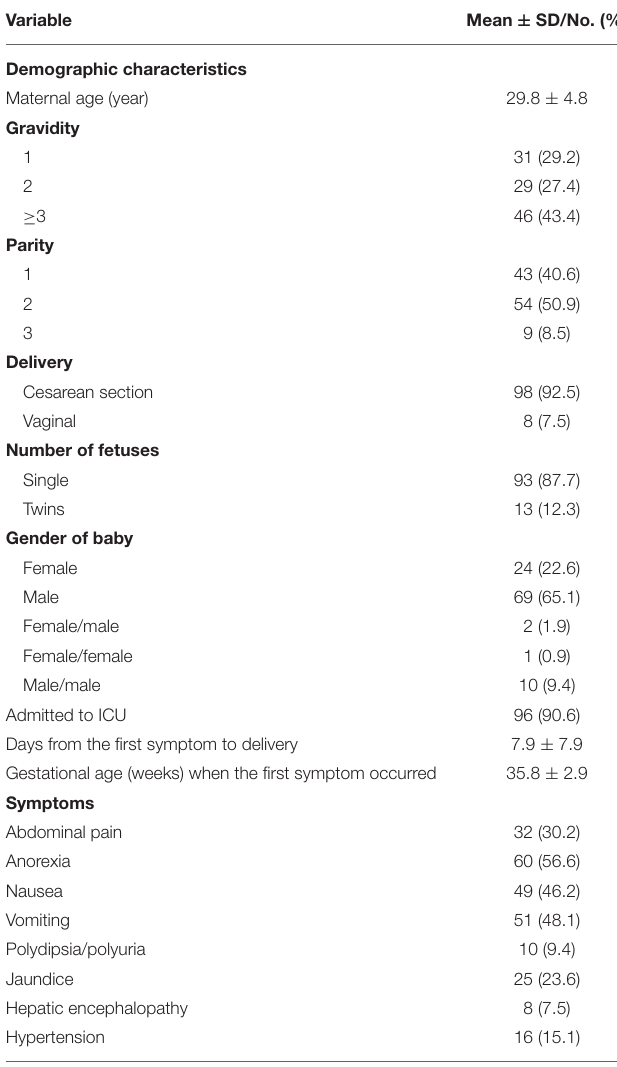
TABLE 2 | Demographic characteristics and clinical symptoms of patients with AFLP ( n =